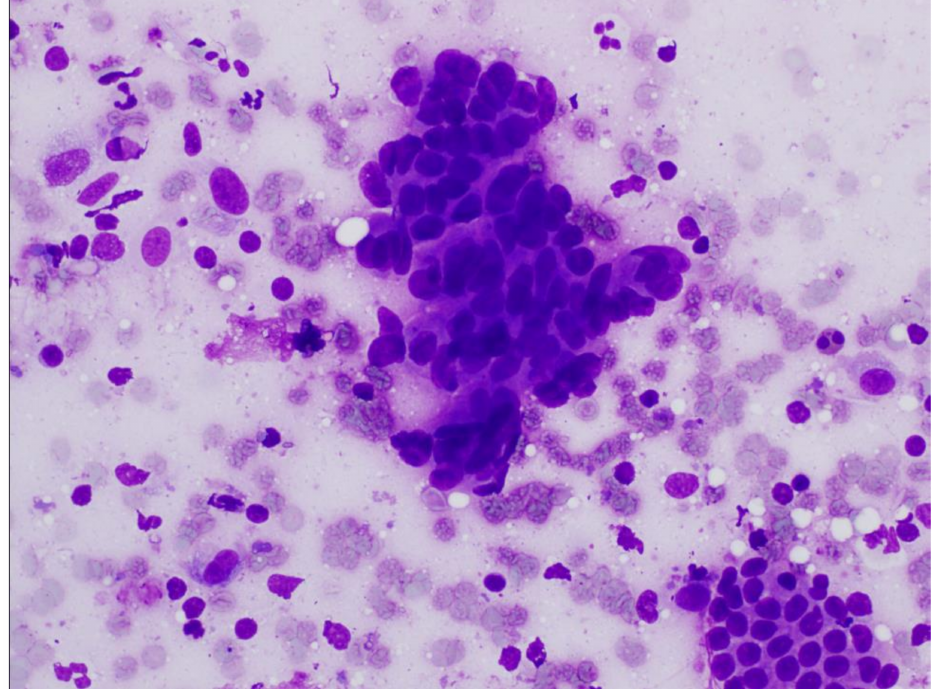
Figure 6. Smear specimen of a ductal adenocarcinoma. The cell group shows significant nuclear crowding, nuclear molding, and marked anisonucleosis. The nuclear/cytoplasmic ratio is greater than 0.7 in the majority of cells. A group of benign ductal cells is in the lower-right corner for comparison (Diff–Quik